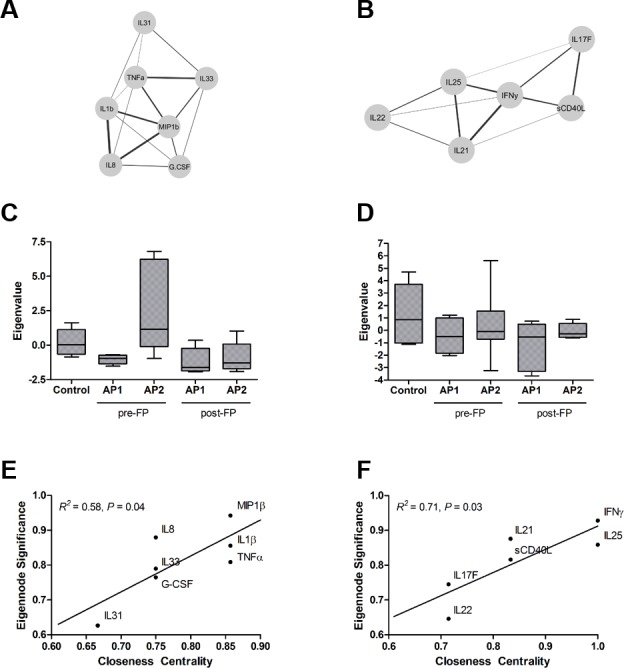
MIP-1β is hub in a cytokine module associated with AP2 pre-FP.Two modules, (A) Module 1 and (B) Module 2, were identified after clustering of cytokines with significant associations. Eigenvalue, linear transformation of cytokine abundances in each module, for (C) Module 1 and (D) Module 2. Hub cytokines were identified by eigennode significance and closeness centrality for (E) Module 1 and (F) Module 2.